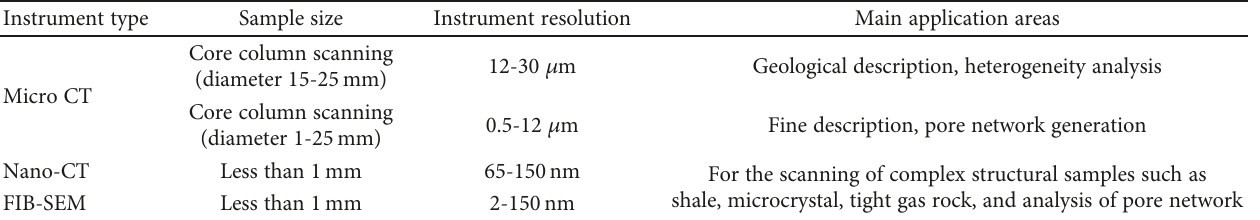
Table 1: Instrument parameters and applications for 3D digital core